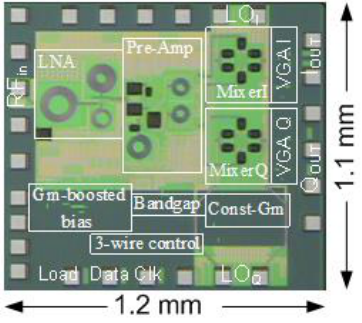
Figure 15. Microphotograph of the 5 GHz software-configurable Doppler radar sensor [75].